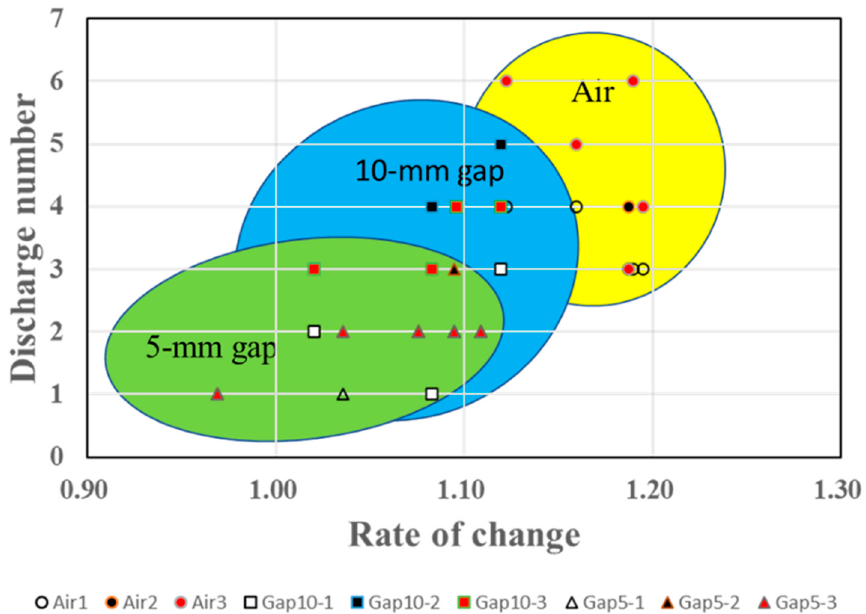
Figure 9. Relationship between removal rate and the discharge number. The removal rates of the HM depend on the number of spark discharges. The condition of airflow and 10 mm gap was the fastest removal of the HMs.